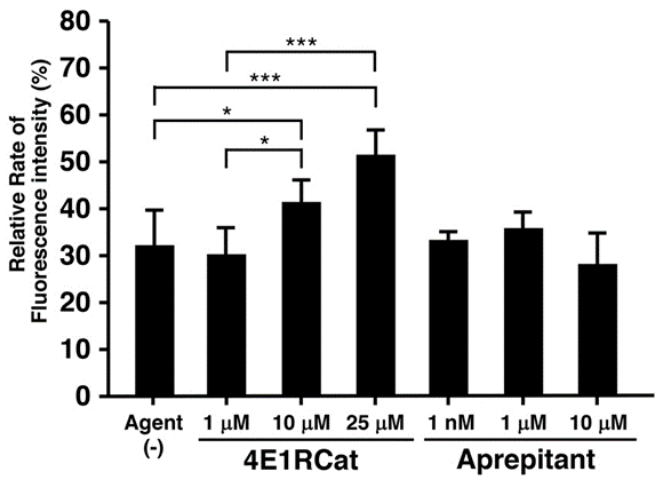
Figure 5. Recovery of nucleotide excision repair (NER) in XPD R683W cells. Two candidate agents chosen in silico, 4E1RCat and aprepitant, were evaluated via the EdU-based unscheduled DNA synthesis (UDS) assay. Data represent means ± SD. Statistical analysis was performed by using one-way ANOVA, and significance was defined as: * p < 0.05, *** p < 0.001 (Agent (-) vs. each concentration of